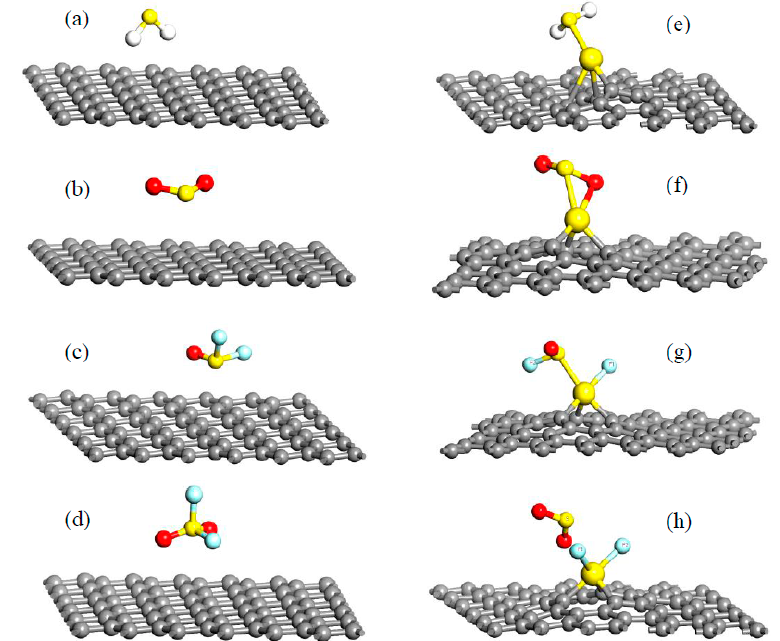
Figure 4. Optimized configurations for H 2 S, SO 2 , SOF 2 , and SO 2 F 2 adsorbed on pristine graphene ( a – d ); optimized configurations for H 2 S, SO 2 , SOF 2 , and SO 2 F 2 adsorbed on Au-graphene ( e – h ). Reproduced with permission from [57]. Copyright 2016 Applied surface science.